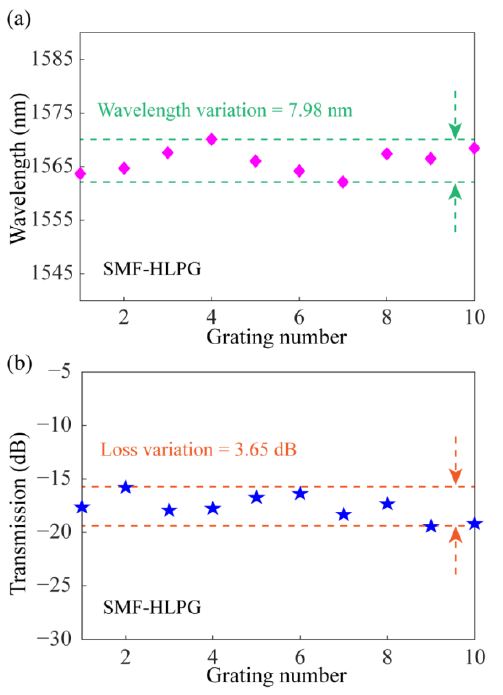
Figure 11. ( a ) The variation of resonance wavelength in the transmission spectra of different SMF- HLPG samples. ( b ) The variation of the transmission loss at the resonance wavelength in the spectra of different SMF-HLPG samples.